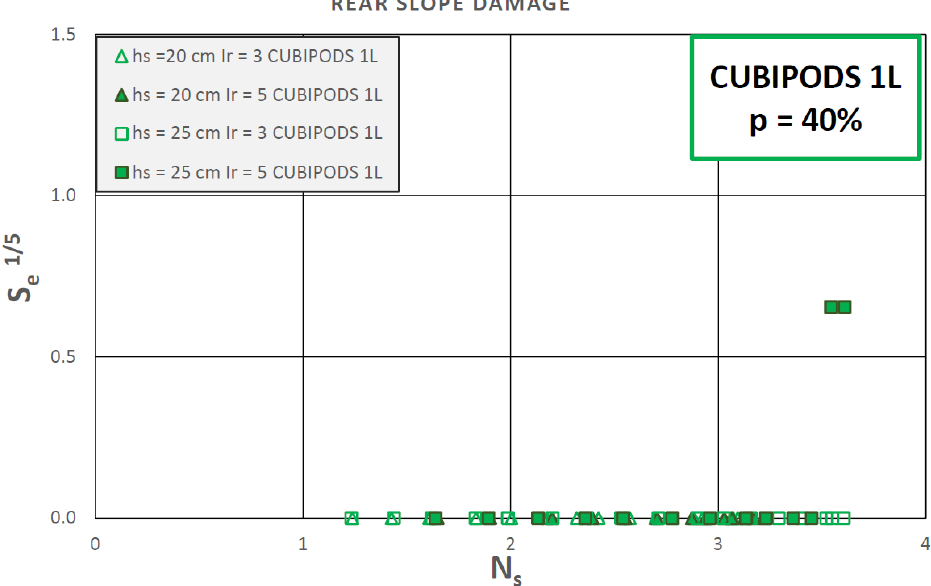
Figure 10. Measured armor damage, S e , to the crest as a function of the stability number (Cubipod ® armor).